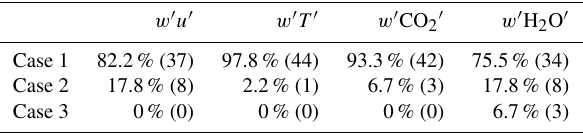
Table 2. Results from ogive analyses. Definitions of cases are given in Foken et al. (2006) and here describe comparisons between 20 and 150min covariance averaging.